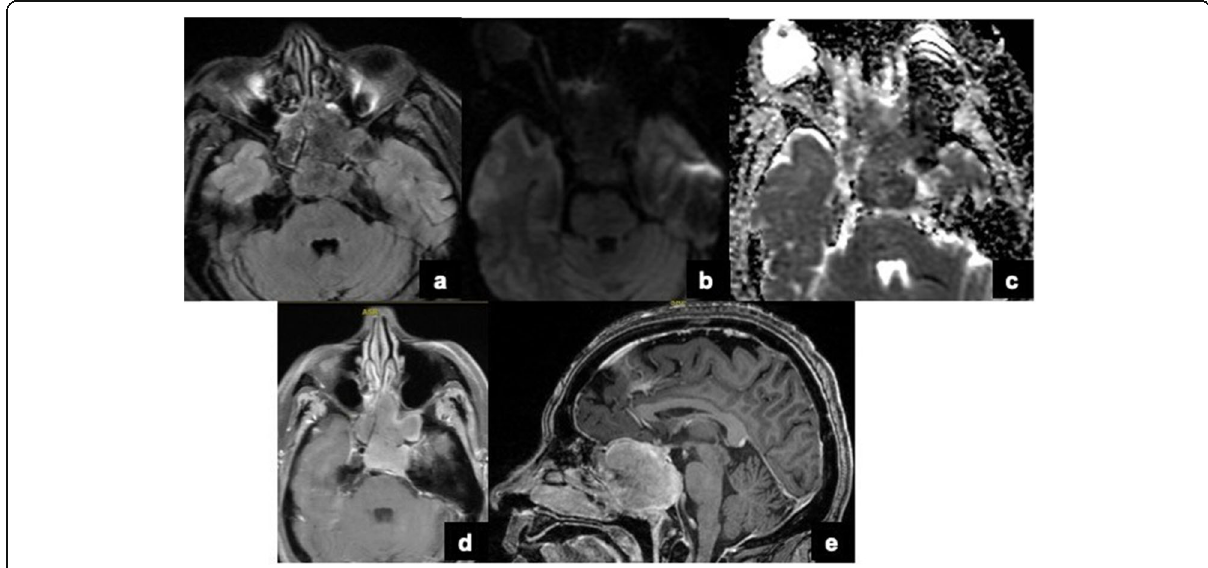
Fig. 3 MRI images ( a ) Lesion appears dark on FLAIR image. Lesion appears dark on diffusion-weighted image ( b ) and apparent diffusion coefficient ( c ) confirming no restriction. Post-gadolinium fat sat axial ( d ) and sagittal ( e ) image shows no significant